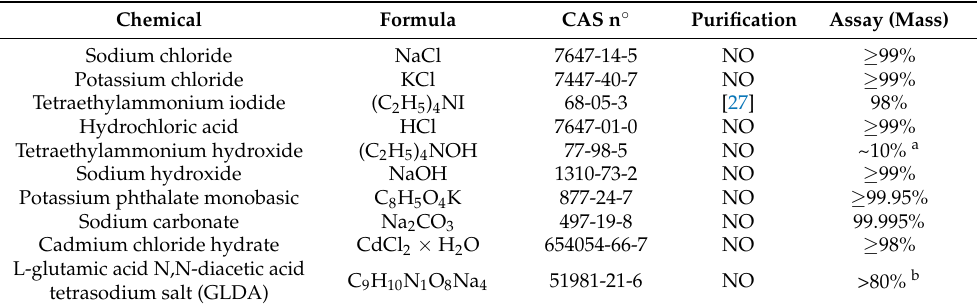
Table 1. Chemicals used in this work, purchased from Sigma-Aldrich. Purity (mass) as stated by the